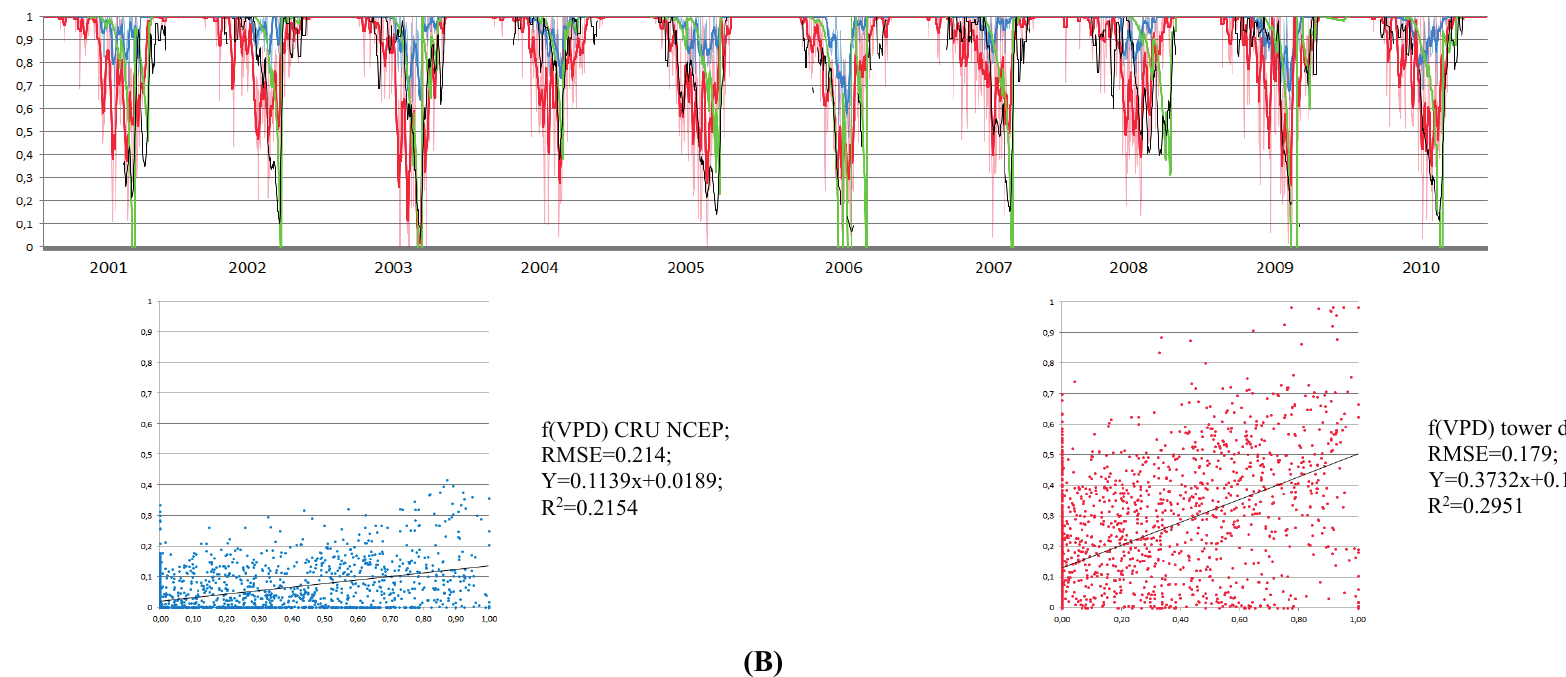
Figure A3. ( A ) daily time course of the MODIS/EC GPP anomaly (black line) for the 2001–2010 period, compared with f(VPD) derived from CRU NCEP daily climate data (blue line), flux tower daily climate data (red line), RE = f(RWC) (green line) and the combined f(VPD)tower x f(RWC) index (yellow line). Relationships between daily MODIS/EC anomalies and beforementionned modifiers are also presented with their corresponding statisitcs (Correlation coefficient R 2 , and Root Mean Square Error (RMSE)). Constant variables for f(VPD) calculations are derived from the Evergreen broadlead Forest type (EBF) from the Zhao and Running (2010) Biome Property Look up table (BPLUT) (Table A1). ( B ) daily time course of the MODIS/EC GPP anomaly (black line) for the 2001–2010 period, compared with f(VPD) derived from CRU NCEP daily climate data (blue line), flux tower daily climate data (red line), RE = f(RWC) (green line) and the combined f(VPD)tower x f(RWC) index (yellow line). Relationships between daily MODIS/EC anomalies and beforementionned modifiers are also presented with their corresponding statisitcs (Correlation coefficient R2, and Root Mean Square Error RMSE). Constant variables for f(VPD) calculations are derived from the Mixed Forest type (MF) from the Zhao and Running (2010) Biome Property Look up table (BPLUT) (Table